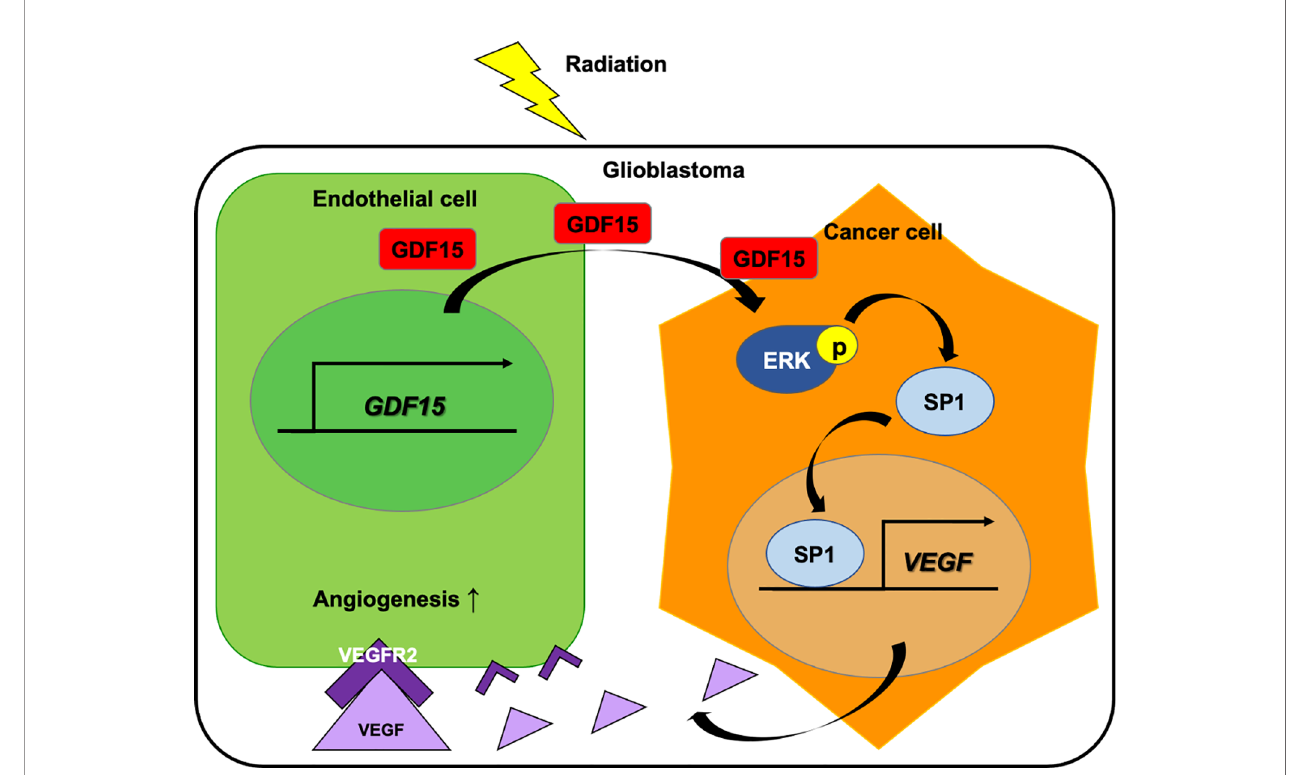
FIGURE 8 | Role of GDF15 in ionizing radiation (IR)-induced angiogenesis in glioblastoma. Radiation upregulates GDF15 expression in the endothelial cells (ECs). EC-derived GDF15 activates the p-MAPK1/SP1 pathway in glioblastoma cells. SP1 stimulates the promoter activity of VEGF. The upregulated VEGF levels induce angiogenesis in glioblastoma through p-KDR on